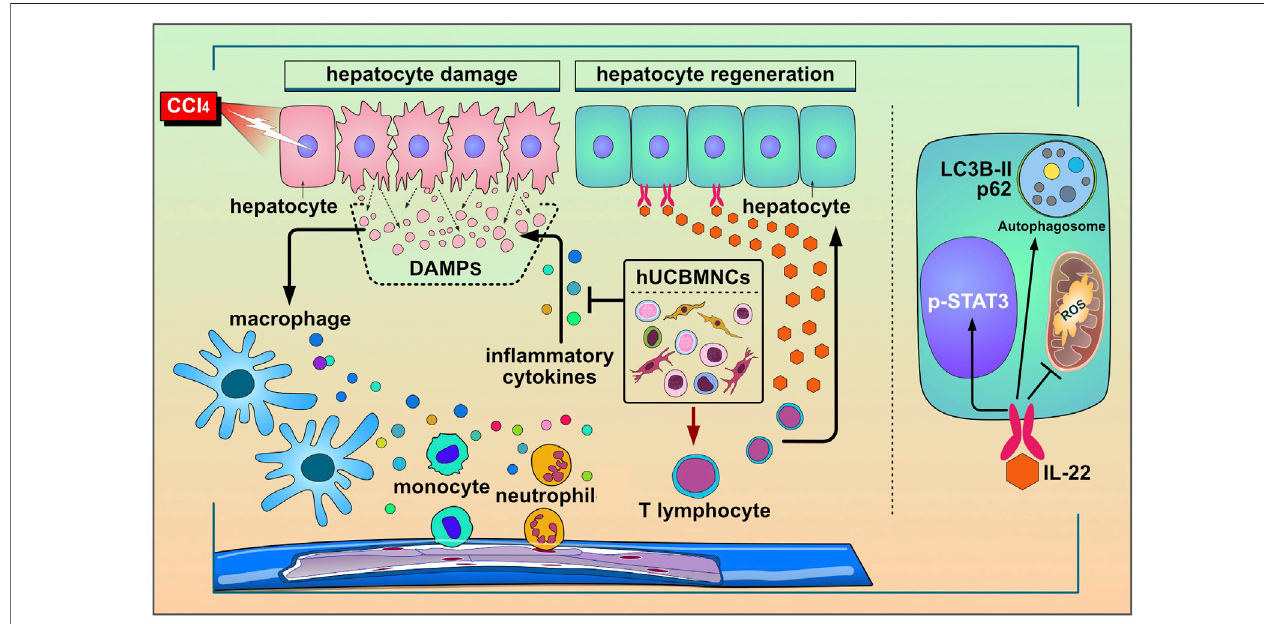
FIGURE7| The workingmodel for theprotectiveroles ofhUCBMNCs in acute liverinjury/failure. hUCBMNCs treatment asakind ofcelltherapeuticstrategycould attenuate CCl 4 -induced acute liver injury/failure in mice with hepatoprotective role, which is executed by enhancing autophagy and regeneration in the liver via inhibiting in fl ammatory responses and upregulating peripheral IL-22.